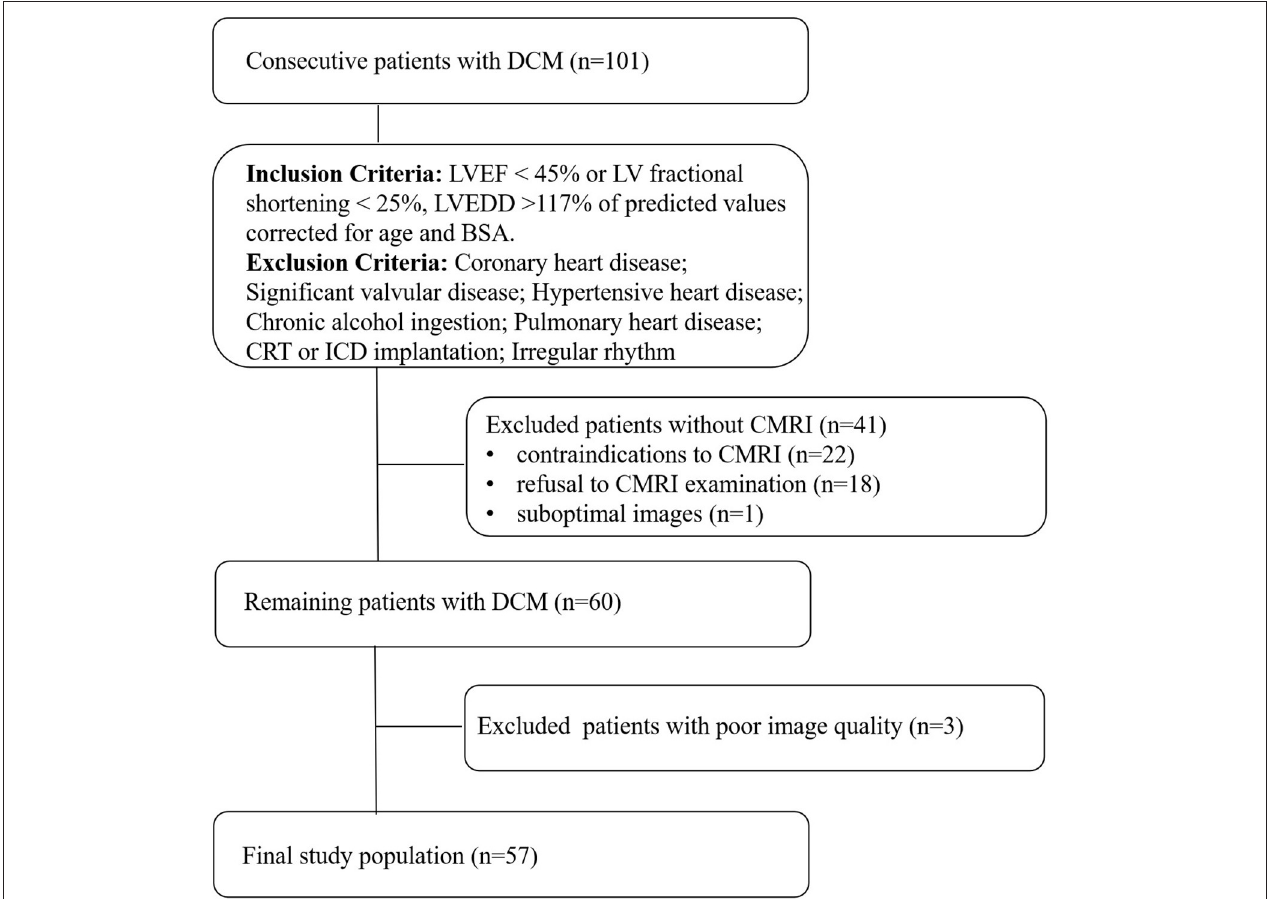
FIGURE 1 | Flow chart detailing the identification of the study cohort. Contraindications to CMRI include incompatible metallic devices, contrast medium allergy, or claustrophobia. Significant valvular disease was defined as valvular stenosis or > mild functional regurgitation. Functional mitral regurgitation was secondary to left ventricular remodeling, mitral valve anatomy was normal. DCM, dilated cardiomyopathy, LVEF, left ventricular ejection fraction, LVEDD, left ventricular end-diastolic diameter, BSA, body surface area, CMRI, cardiac magnetic resonance imaging, CRT, cardiac resynchronisation therapy, ICD, implantable cardioverter